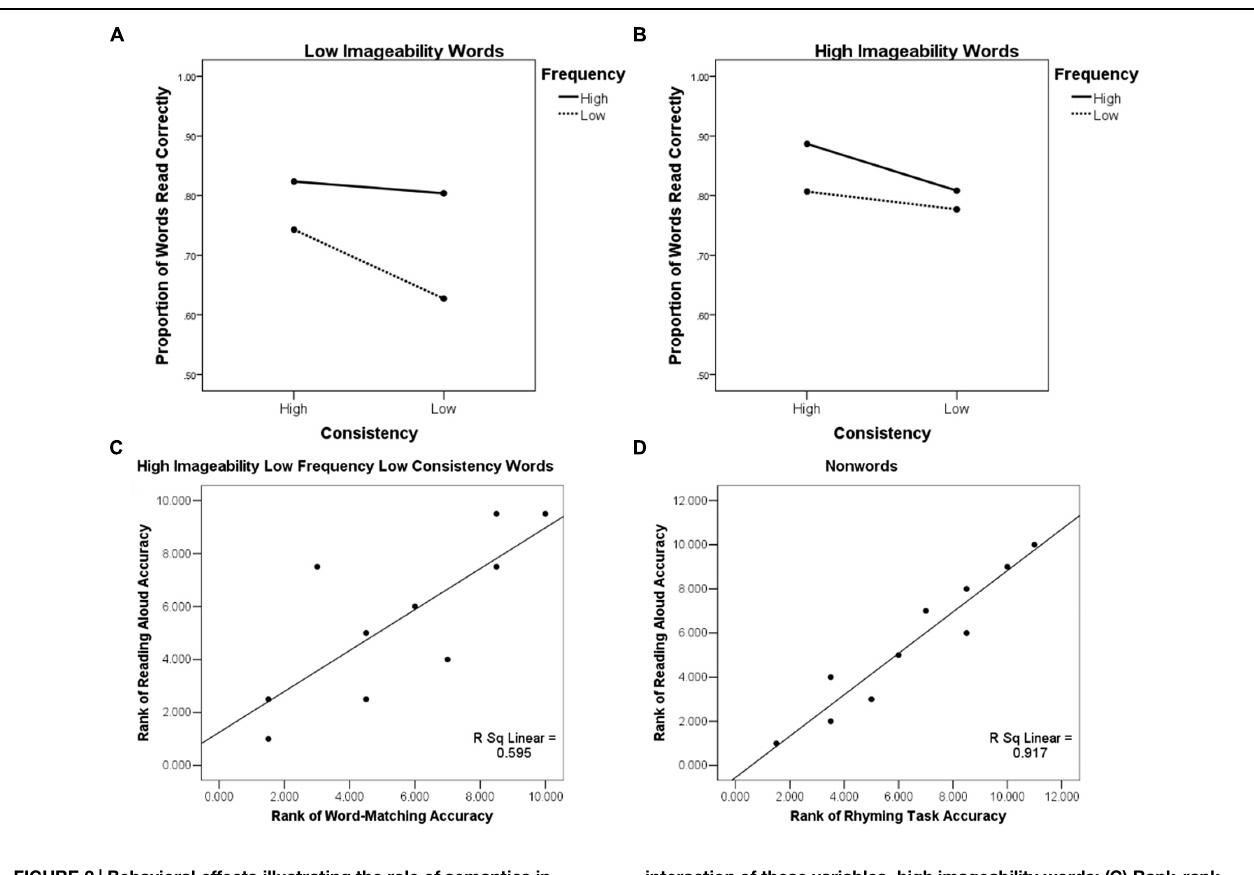
FIGURE 2 | Behavioral effects illustrating the role of semantics in reading aloud: (A) Patient accuracy in the reading aloud task as a function of word imageability, frequency, and consistency showing a three-way interaction of these variables, low imageability words; (B) Patient accuracy in the reading aloud task as a function of word imageability, frequency, and consistency showing a three-way